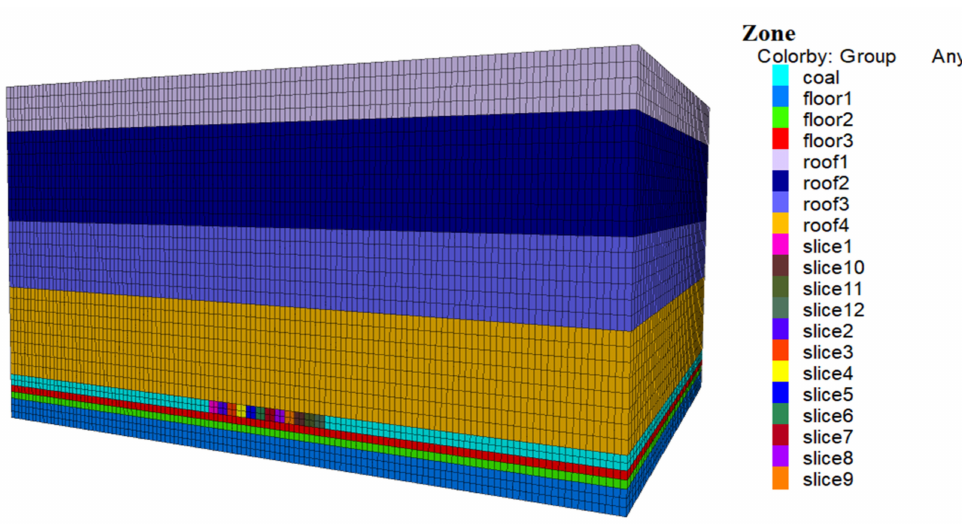
Figure 6. Coal panel simulation. Table 3. The physical and mechanical properties of rock lithology in the numerical